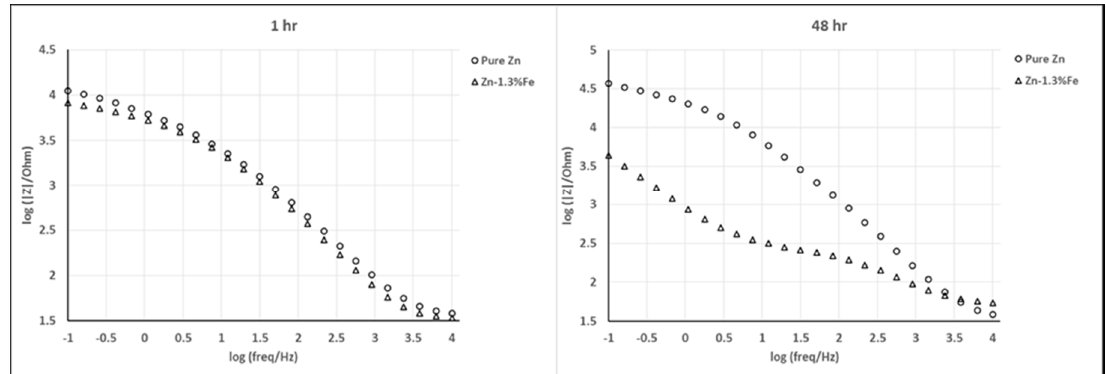
Figure 9. Bode plots obtained after immersion in PBS solution for up to 48 h.